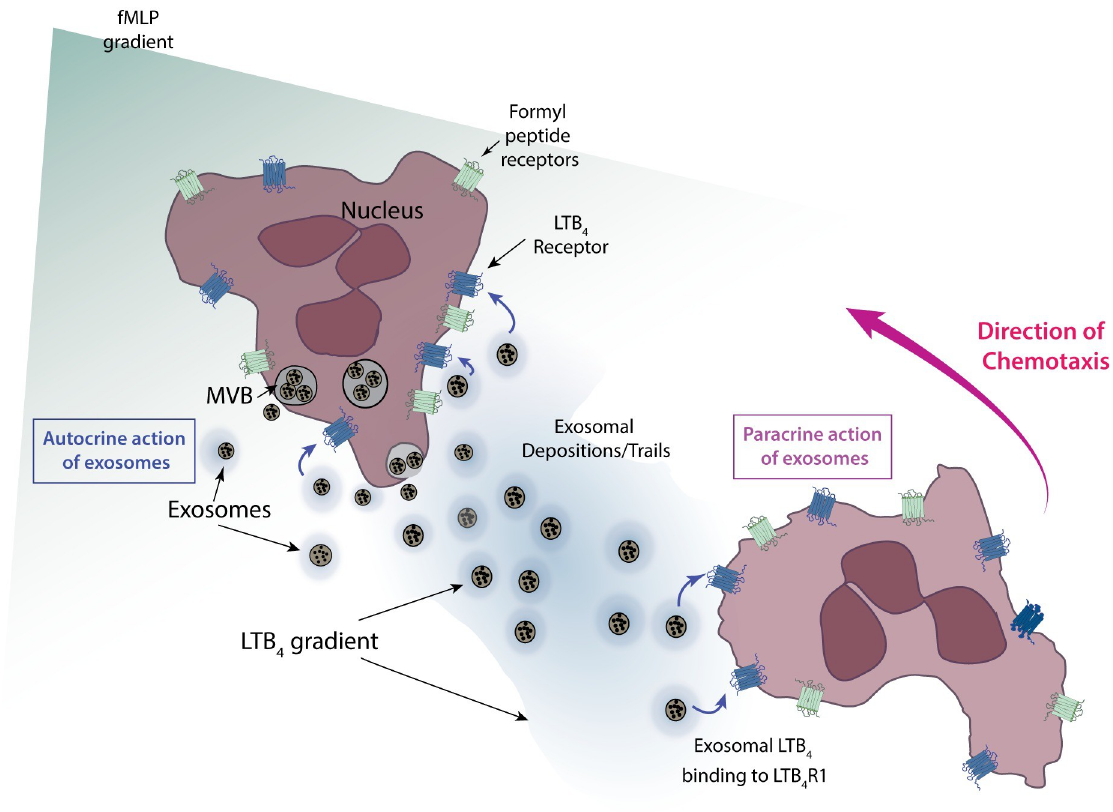
Fig 7. Illustration depicting exosome mediated LTB 4 relay in neutrophils chemotaxing to fMLP. Cartoon depicting 2 neutrophils chemotaxing toward an fMLP gradient (green). LTB 4 released from exosomes are shown in blue. See text for details. fMLP, N- formylMethionyl-Leucyl-Phenylalanine; LTB 4 , leukotriene B 4 ; LTB 4 R1, receptor for LTB 4 ; MVB, multivesicular body.